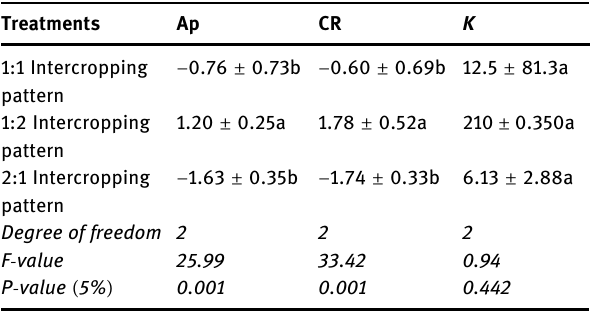
Table 4: Competitive intensity ( Ap, CR, and K ) on intercropping